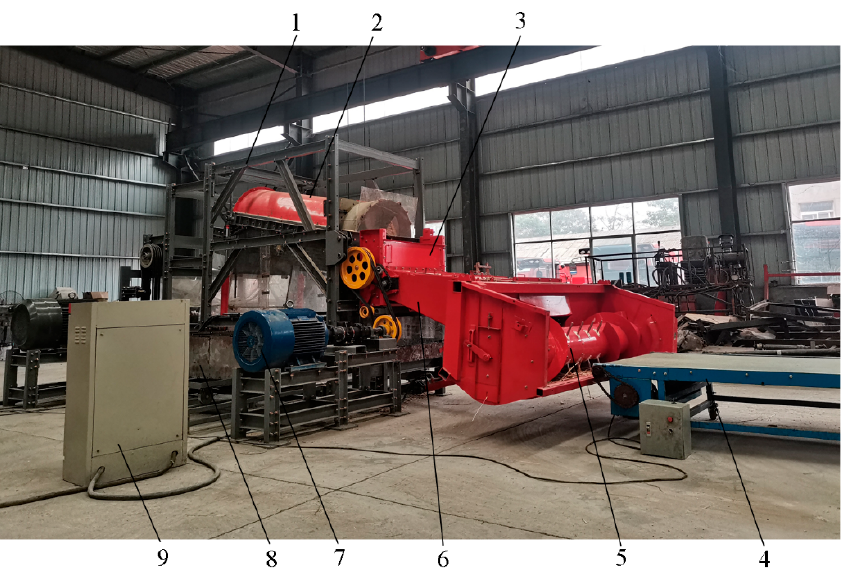
Figure 3. Structural view of the threshing test bench. 1. Frame; 2. Longitudinal axial flow threshing and separating device; 3. Tangential flow threshing and separating device; 4. Material conveying platform; 5. Inclined conveyor; 6. Screw conveyor; 7. Motor; 8. Grain collection boxes; 9. Frequency converter.